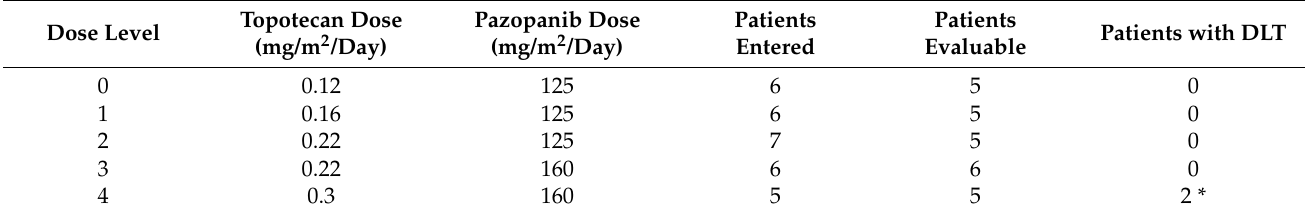
Table 2. Summary of dose levels and dose-limiting toxicities in cycle